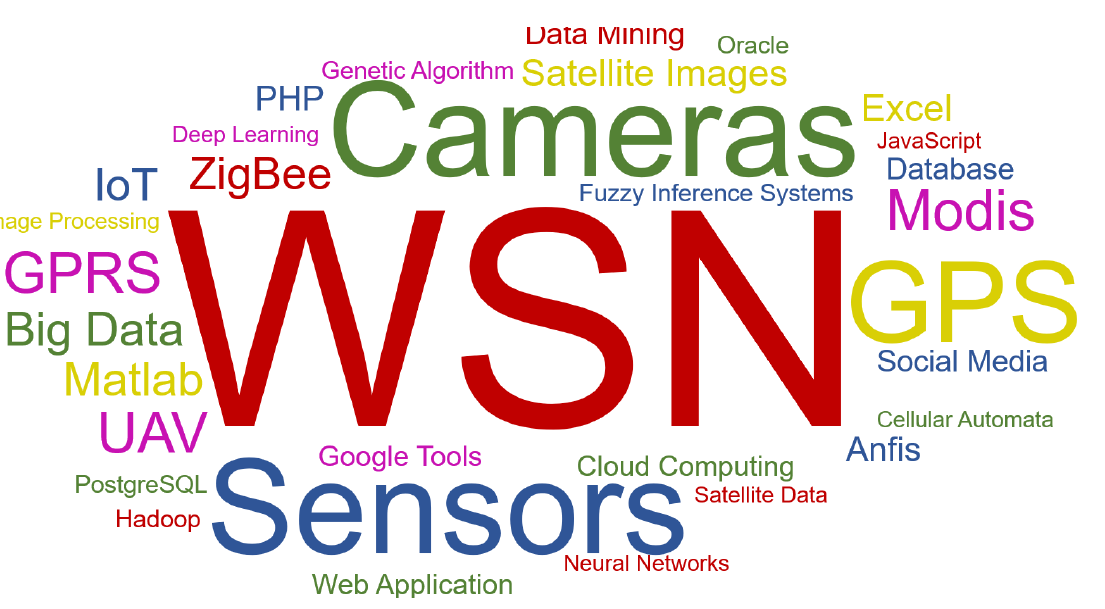
Figure 9. Word cloud of the technologies.